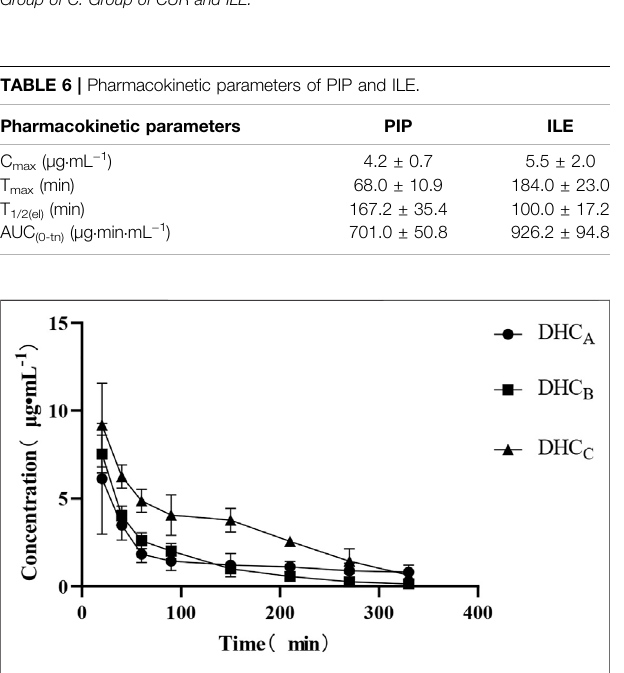
FIGURE 4 | Drug-time curve of DHC. Group of A: Group of CUR, Group of B: Group of CUR and PIP, Group of C: Group of CUR and ILE.